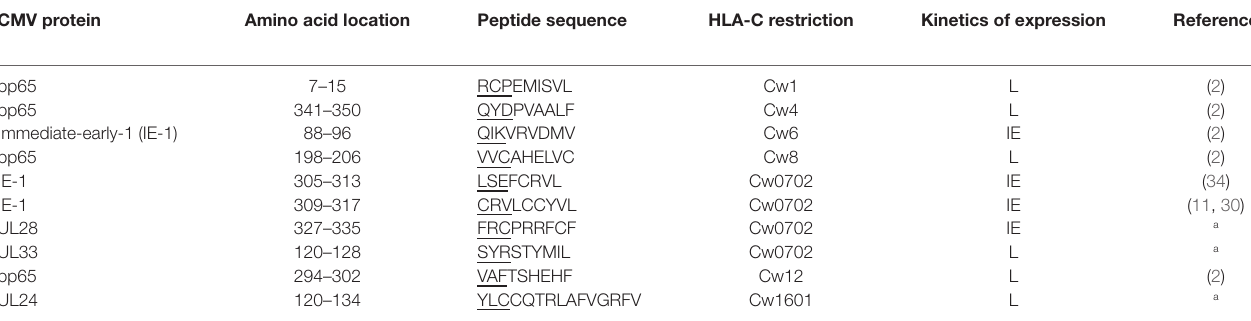
Table 1 | List of cytomegalovirus (CMV) epitopes restricted by HLA-C. cMV protein amino acid location Peptide sequence hla-c